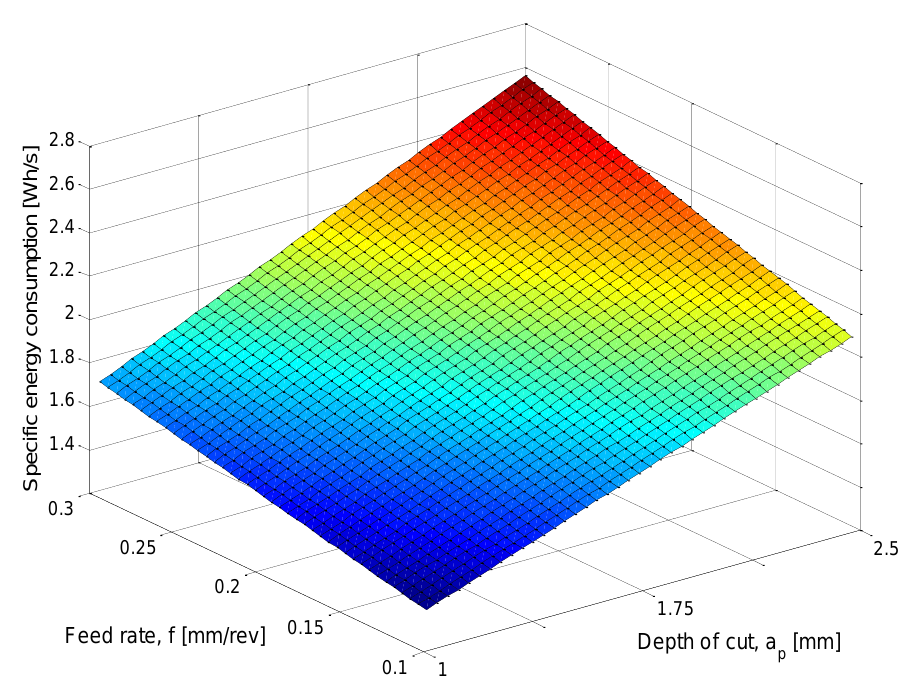
Figure 14. Change in STEC with respect to feed rate and depth of cut.